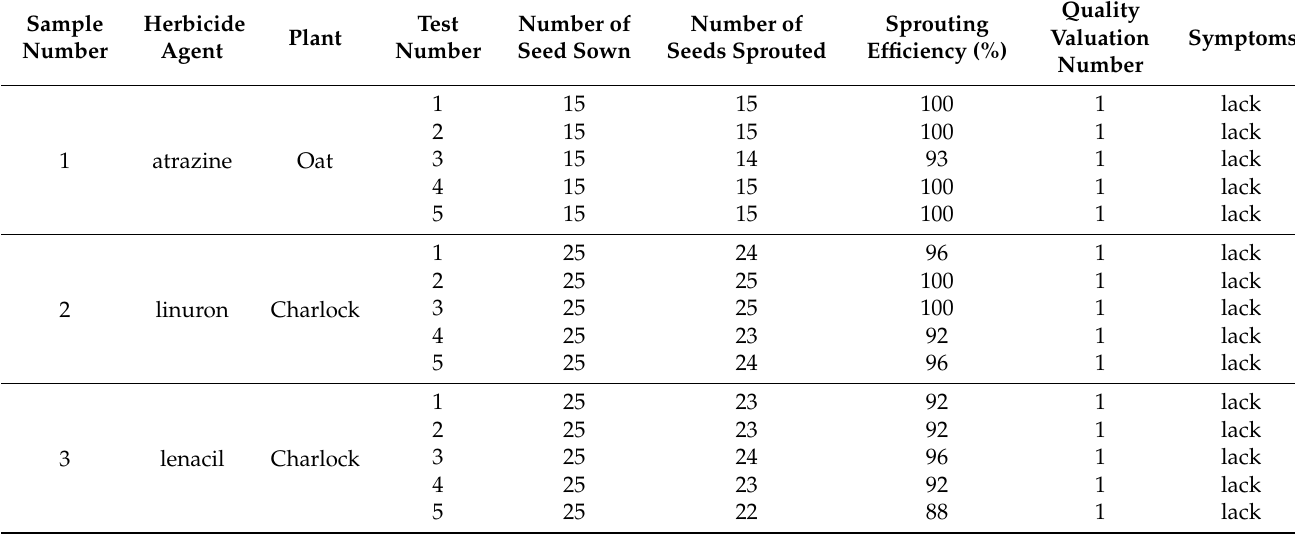
Table 5. Results of the 1st series of biological